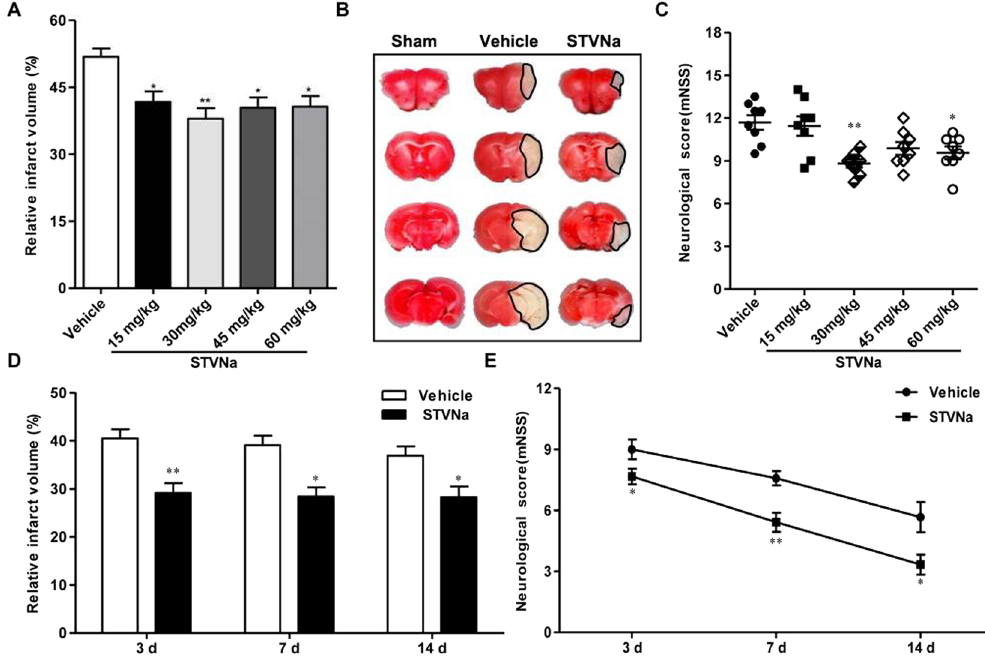
Figure 1. Effect of STV-Na on behavioral deficits and brain infarct volume in mice with MCAO/R injury. Multiple tests were performed in mice that underwent 1 h of ischemia followed by 1 d, 3 d, 7 d or 14 d of reperfusion. ( A ) Dose-dependent effects of STV-Na on infarct volumes evaluated by TTC at 24 h (n = 6 per group). ( B ) A sample of brain slices TTC staining at 24 h after MCAO/R. ( C ) MNSS was evaluated at 24 h (n = 6 per group). ( D ) Effects of STV-Na on infarct volumes at different time points (n = 6 per group). ( E ) MNSS was evaluated at different time points (n = 6 per group). Data are represented as mean ± SD, * P < 0.05, ** P <